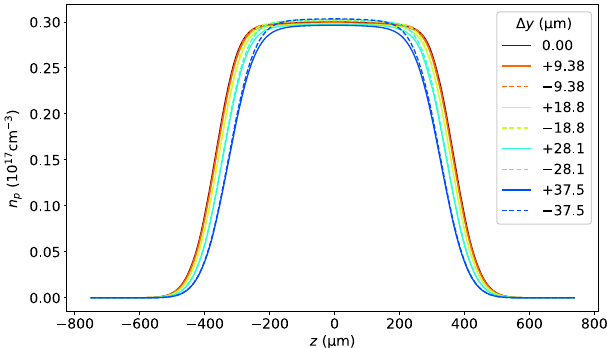
FIG. 5. Laser-ionized plasma density profile ( n p ) along the electron beam propagation axis at several vertical positions ( Δ y ) measured with respect to the center of the plasma lens.